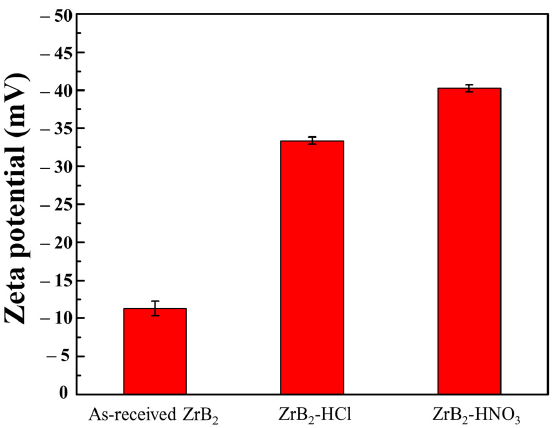
Figure 4. Zeta potentials of as-received ZrB 2 , HCl-treated ZrB 2 , and HNO 3 -treated ZrB 2 particles.